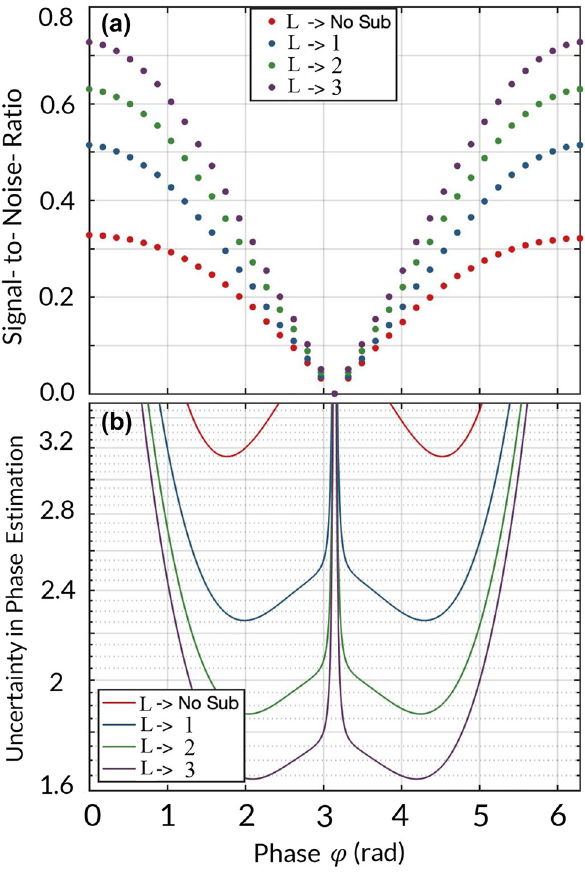
Figure 4: The panel in (a) reports the signal-to-noise ratio (SNR) as a function of 𝜑 for the conditional detection of the plasmonic modes transmitted by a 320-nm nanoslit. The red dots represent the unconditional SNR. Furthermore, the blue, green, and purple dots indicate the SNR for the subtraction of one, two, and three plasmons, respectively. This plot shows the possibility of improving the SNR of our plasmonic sensor through the subtraction of plasmons. The panel in (b) indicates that an increasing SNR leads to lower uncertainties in the estimation of phase shifts induced by analytes. The lower uncertainties described by Δ 𝜑 imply higher sensitivities of our plasmonic